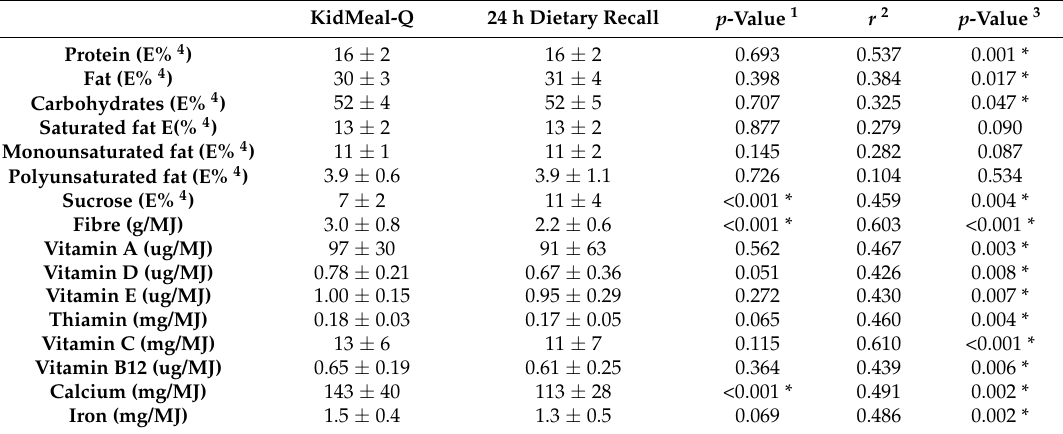
Table 3. Mean intakes and correlations for selected nutrients estimated by KidMeal-Q and 24 h dietary recalls ( n = 38).